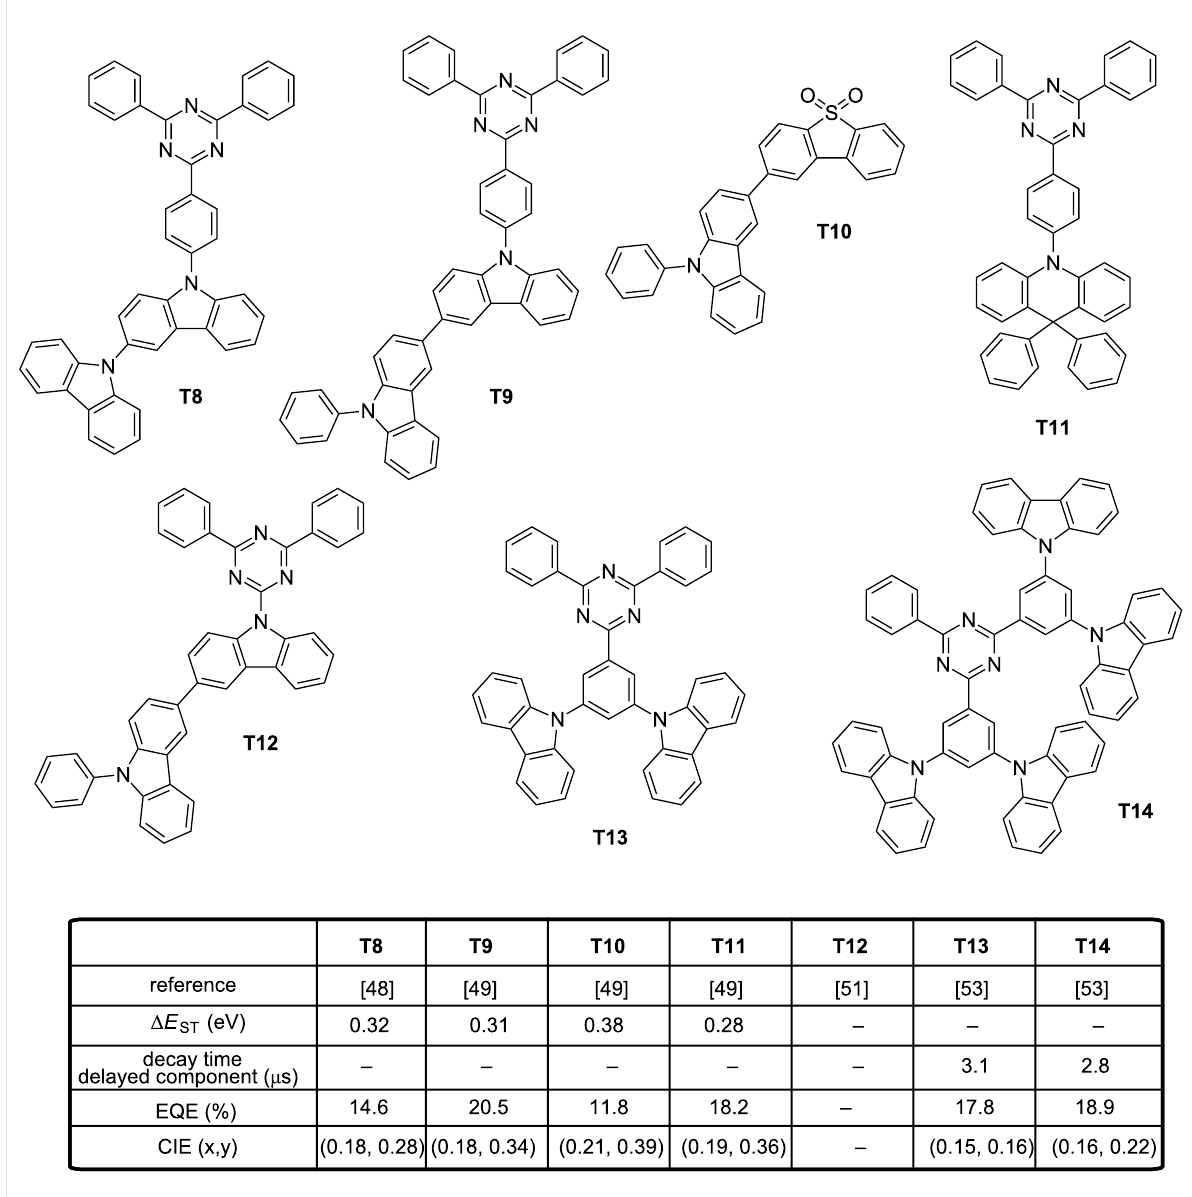
Figure 5: Triazine-based TADF emitters T8 , T9 , T11 – T14 and carbazole derivative T10 .